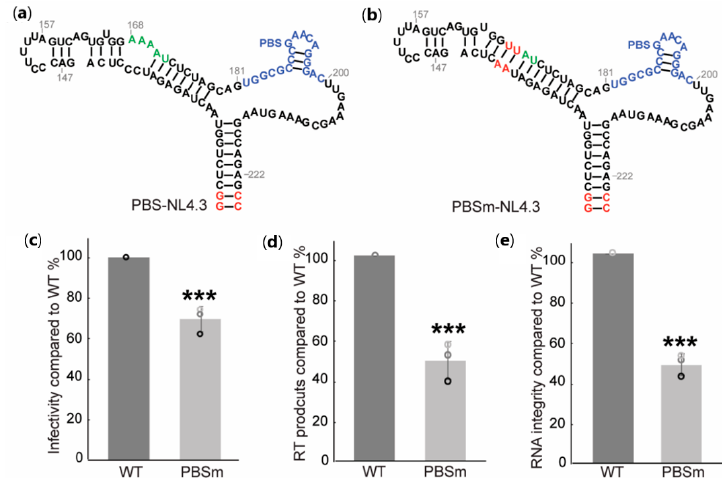
Figure 5. Cell-based assays show the A-rich loop residues are important for viral replication in human immunodeficiency virus 1 (HIV-1) subtype B. ( a ) Predicted secondary structure of PBS-NL4.3 RNA. The A-rich loop is labeled in green, the primer binding site is labeled in blue, and the non-native nucleotides are labeled in red. ( b ) Predicted secondary structure of PBSm-NL4.3 RNA. A PBS that is complementary to the 3 ′ -18-nt of tRNA Lys3 is labeled in blue, and the non-native nucleotides are highlighted in red. ( c ) Mutation of A-rich loop lowered the infectivity of the pseudo-typed virus in the single-round infectivity assays. The infectivity was quantified by measuring the EGFP signals and normalizing the p24 levels of the virions, and the infectivity of the mutants was normalized to the WT in each parallel experiment. ( d ) Mutation of the A-rich loop reduced the reverse transcription products 2 h post-infection. ( e ) Mutation of the A-rich loop resulted in reduced vRNA integrity in the genomic integrity assay. Graphs are representative of three independent experiments, average ± standard deviation; *** p < 0.001.